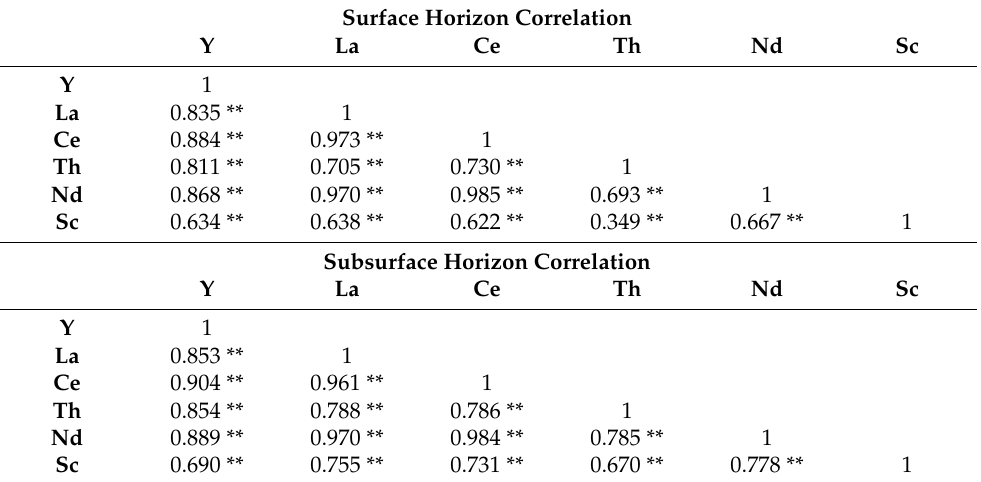
Table 2. Correlation matrix of elements.